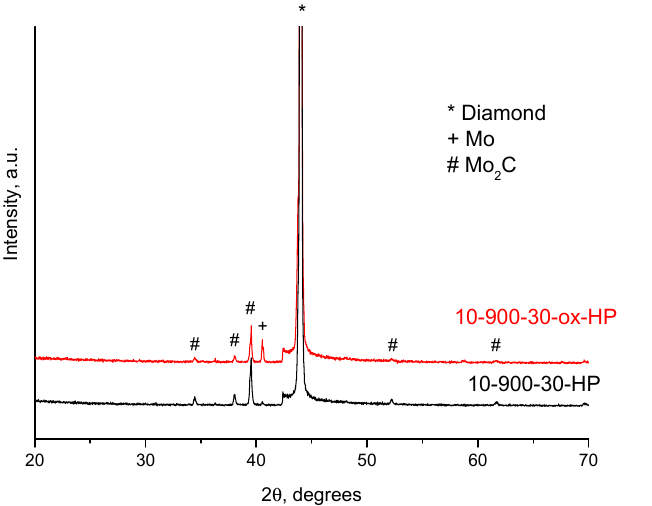
Figure 6. Surface of a diamond crystal, 10-900-30-ox-HP.